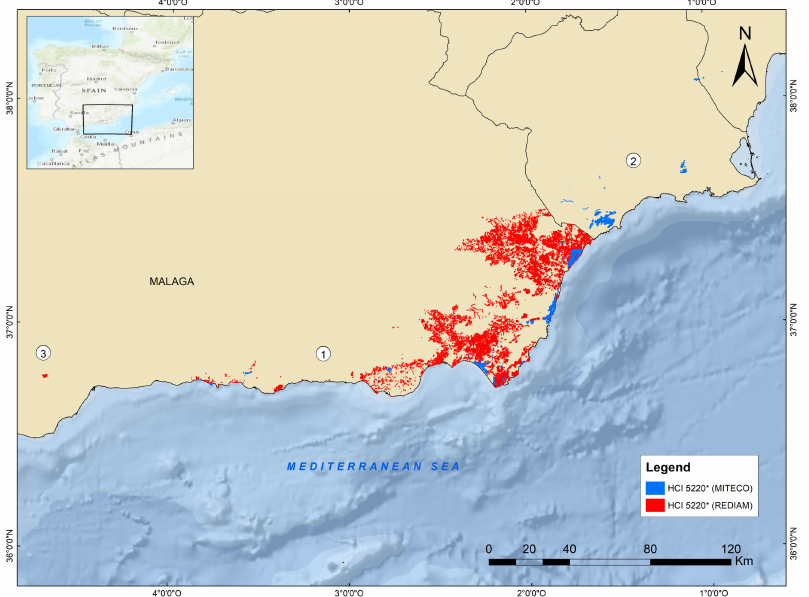
Figure 1. Distribution of the 5220* Priory Habitat in the Iberian Peninsula. HCI: Habitat of Commu- nitarian Interest. Blue represents the 5220* HCI mapped by the Spanish government (MITECO) [13], red represents the 5220* HCI mapped by the Andalusian environmental network [4]. 1. Main nucleus of 5220*HCI; 2. Easternmost and isolated nucleus of 5220* HCI; 3. Westernmost and isolated nucleus of 5220* HCI. The data source of the general cartography: Ocean Basemap layer from ESRI. Gymnosporia senegalensis (Lam.) Loes. (= Maytenus senegalensis (Lam.) Exell) is